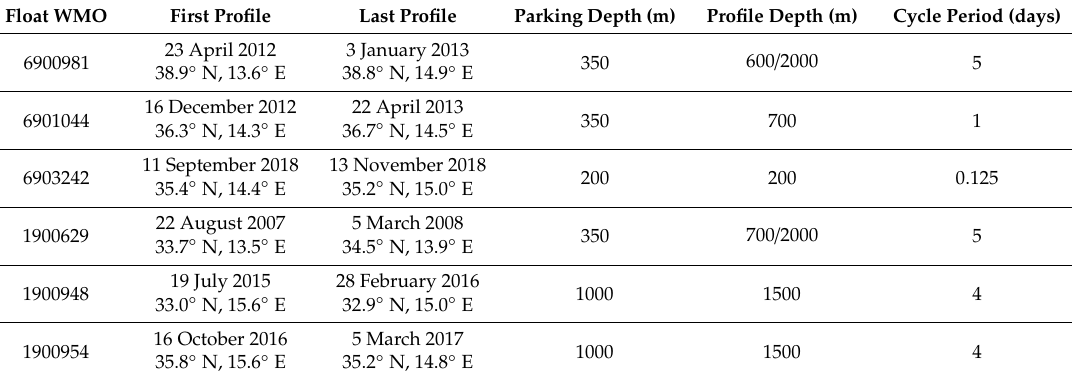
Table 2. List of selected Argo float profiles with dates and positions of the first and the last profile considered in this work, parking and profiling depths, and the cycle period of each